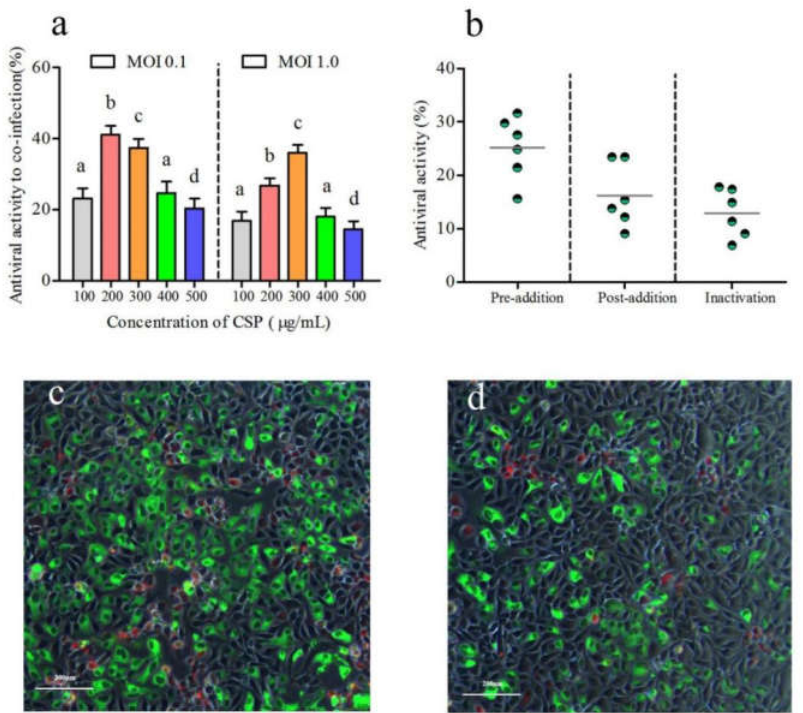
Figure 5. The antiviral ability of CSP on the co-infection of IHNV and IPNV. ( a ) The antiviral activity of CSP on the co-infection of IHNV and IPNV with a MOI of 0.1 and 1.0, respectively. ( b ) The antiviral activity of CSP on IPNV under the pre-addition, post-addition, and inactivated treatments. ( c ) IFAT result of the co-infection without the presence of CSP. ( d ) IFAT result of the co-infection with the presence of CSP. Different letters indicate statistical significance, p < 0.05).